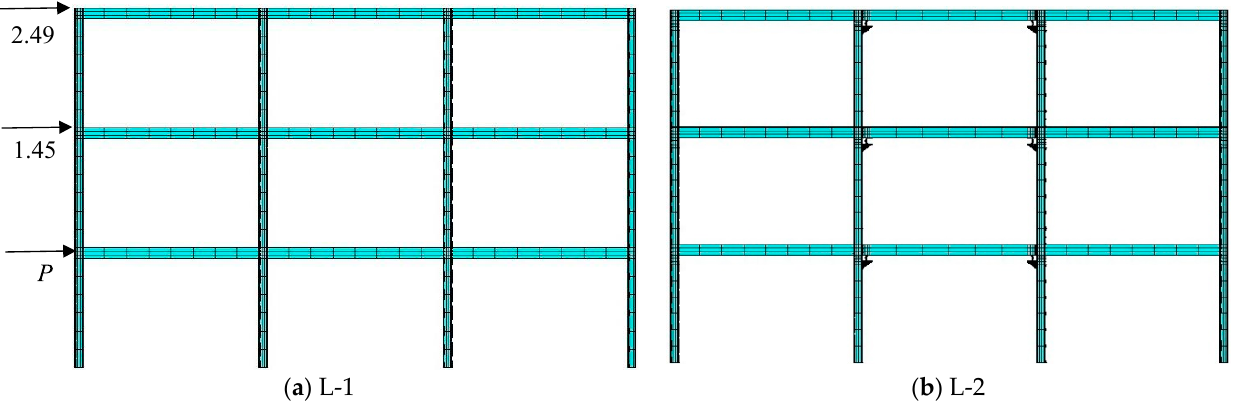
Figure 16. A multi-story rigid frame finite element model.